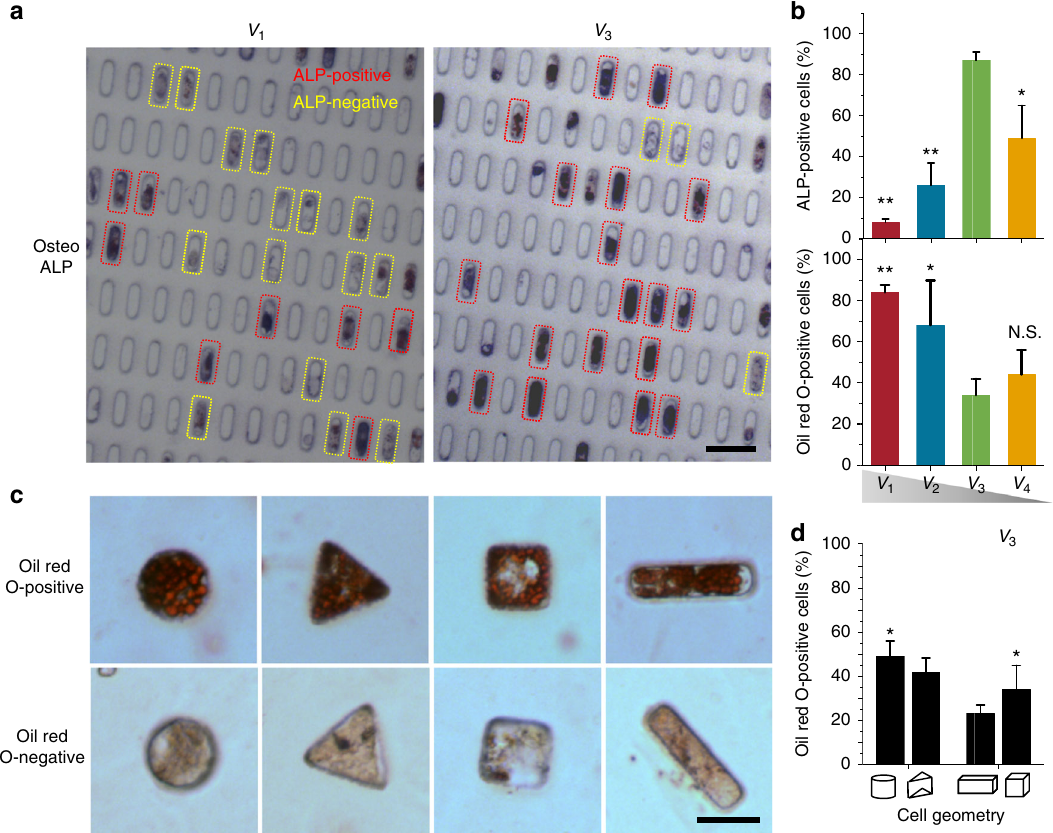
Fig. 6 Size and geometry affect single hMSC fate. a Alkaline phosphatase (ALP) staining for cells with different V 1 and V 3 volume. The ALP-positive cells were determined by applying an optimal threshold to the image; ALP intensity above the threshold was determined as ALP positive. b Quanti fi cation of differentiation after 7 days (ALP) and 10 days (Oil Red O) for cells with different volumes. c Representative images show Oil Red O positive and negative staining for cells with volume ( V 3 ) but different geometries. d Quanti fi cation of adipogenic differentiation after 10 days for cells with different geometries. Mean ± s.d., ANOVA one-way analysis followed by Tukey post-hoc test shows signi fi cance levels of * P < 0.05, ** P < 0.01. NS no signi fi cant difference. N ≥ 6 regions of interest (ROI) with a total of 150 – 200 cells analyzed. Scale bar 20 µ